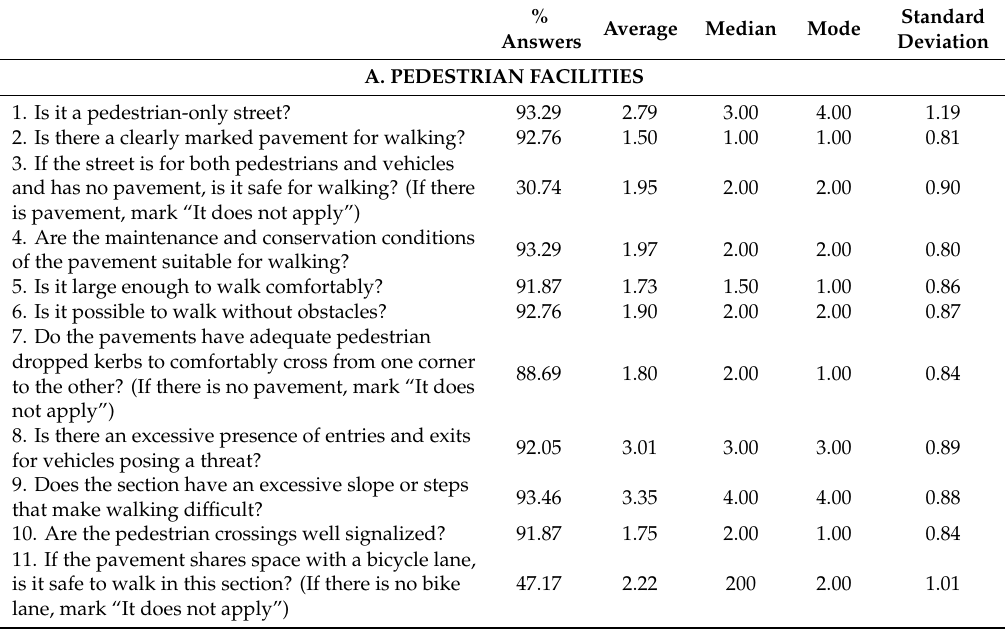
Table 1. Description of items of the urban walkability perception questionnaire